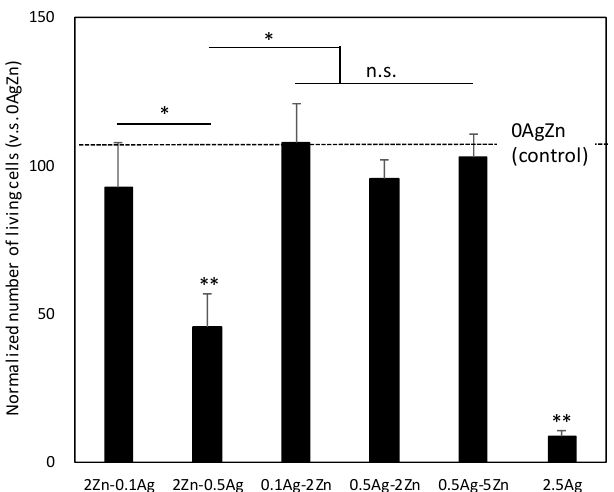
Figure 6. Normalized number of living cells on each specimen 72 h after seeding (* statistically significant difference, p < 0.05; n.s.: no significant difference; ** statistically significant difference against 0AgZn, p < 0.05). Measurements were performed on five equally conditioned specimens ( n = 5).